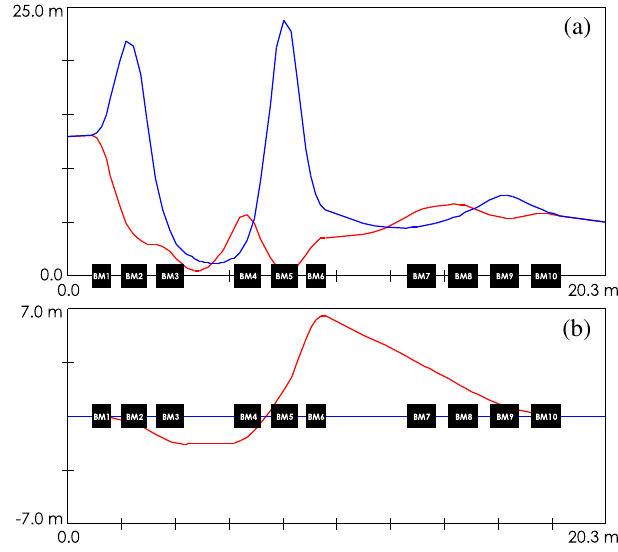
FIG. 3. (a) Beta and (b) dispersion functions of the beam line in the rotating gantry. The blue and red lines show those for the horizontal and vertical coordinates, respectively.